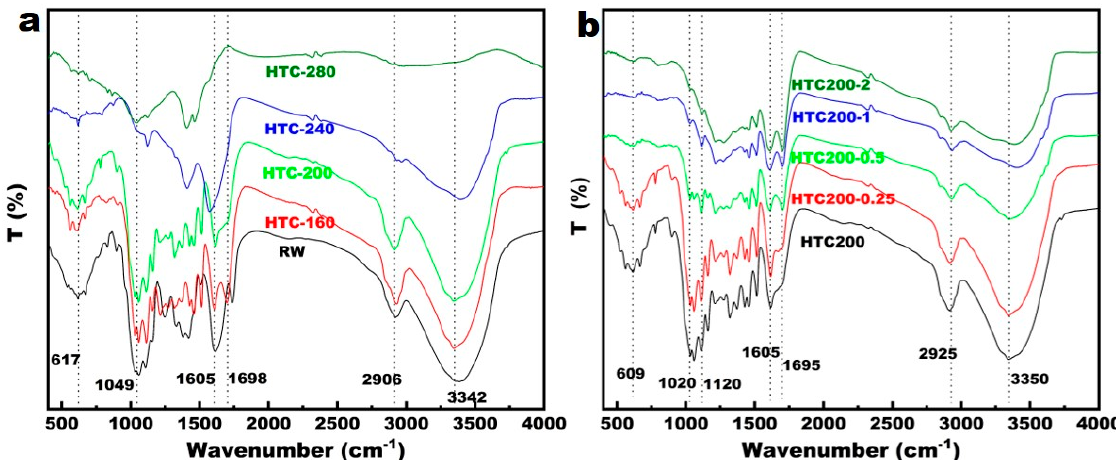
Figure 5. The relative percentages (% of total) of heavy metals (Pb), (Zn), (Cu), (Cd) existing in F1, F2, F3 and F4 in hydrochars with different HCl concentrations.